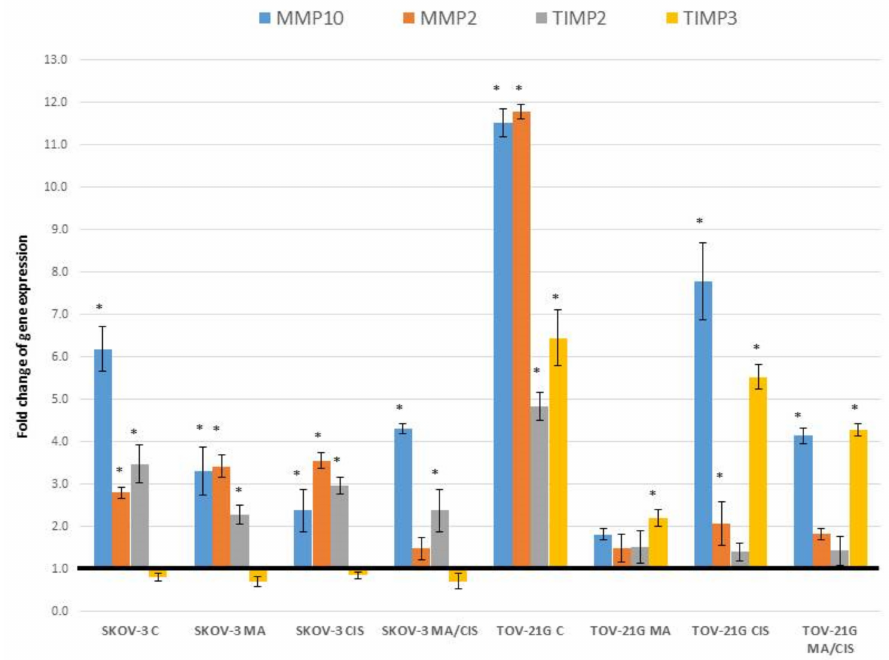
Figure 2. Effect of exosomes derived from SKOV-3 and TOV-21G cells (untreated with drugs, α - mangostin and/or cisplatin-treated) on the expression of extracellular matrix markers in fibroblasts. The data are shown as mean ± SD of triplicate experiments, statistically significant results * ( p <